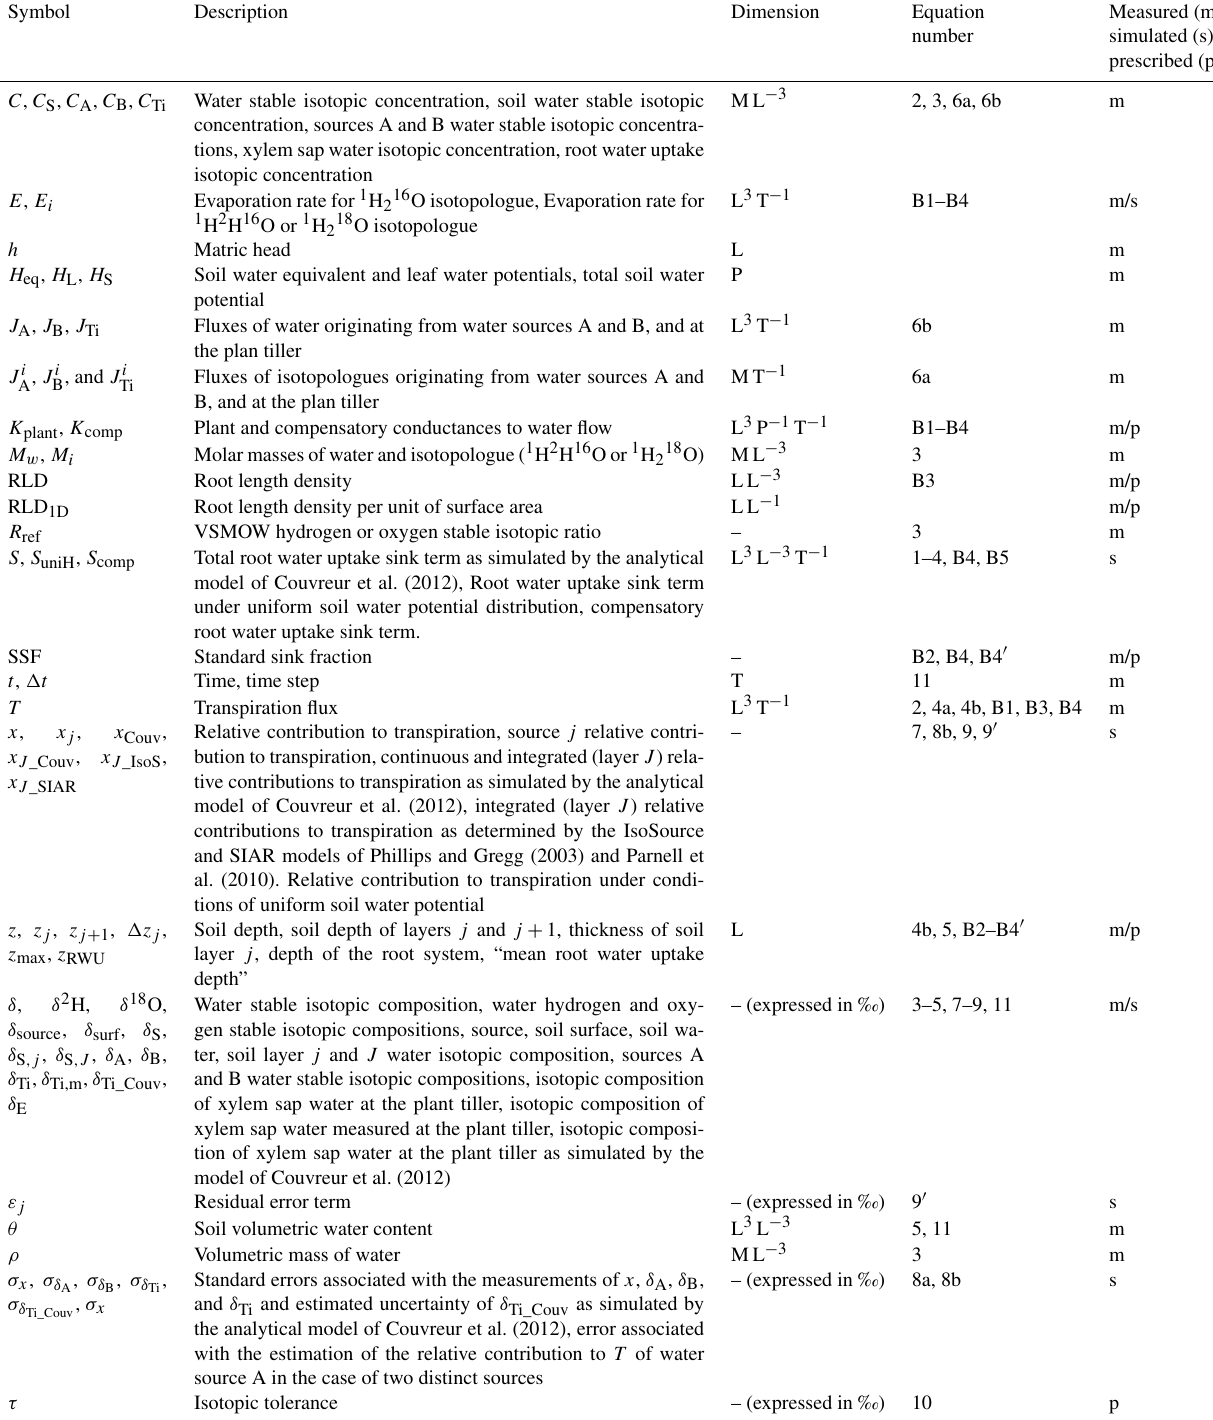
number simulated (s)/ prescribed (p)